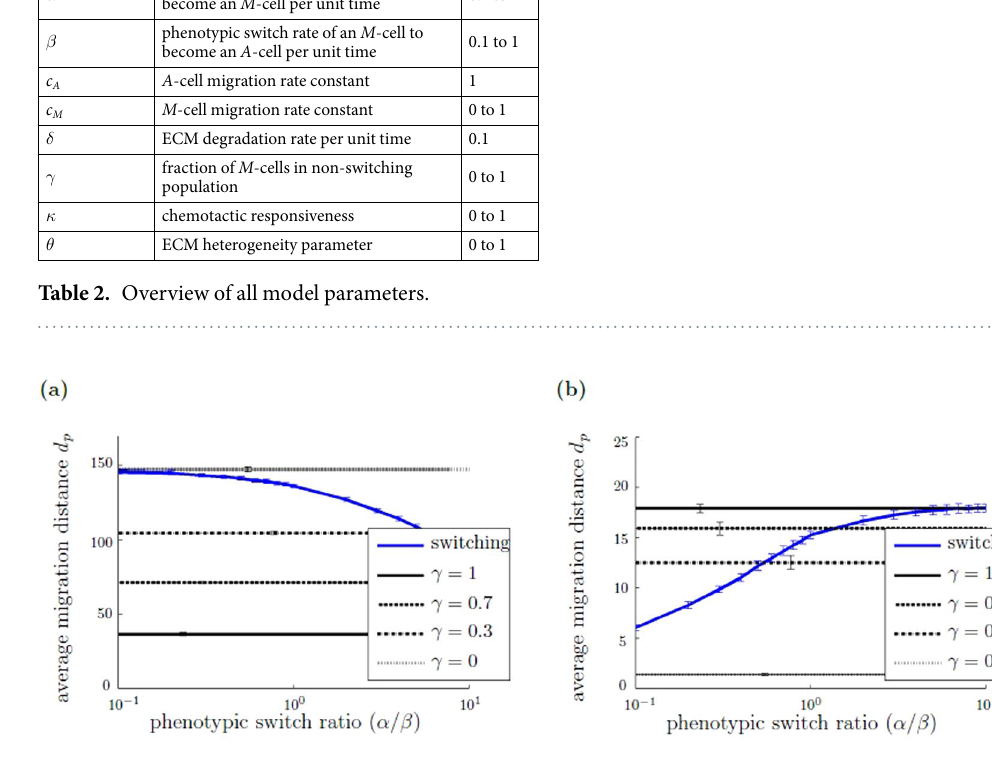
Figure 4. Advantage of non-switching behavior under homogeneous ECM conditions. The figure shows the average migration distance dp of switching and non-switching populations depending on the switch ratio α / β for different homogeneous ECM conditions: ( a ) homogeneous, low ECM resistance modeled by μ ( r 1 , r 2 ) = 0.1 and ( b ) homogeneous, high ECM resistance with μ ( r 1 , r 2 ) = 0.9. The blue line represents the switching populations, the black lines display non-switching populations with different M -cell fraction γ ∈ . . {0,0 3,0 7,1} . Each simulation is run with 50 cells. Simulations are evaluated after 200 Monte Carlo steps, averaged over 50 independent simulations. The errorbars show the standard deviation of the average migration distance d p between the simulations. The standard deviation within the simulations is shown in Supplementary Fig. S5. Simulation parameters are c M / c A = 0.25, κ = 1, δ = 0.1.